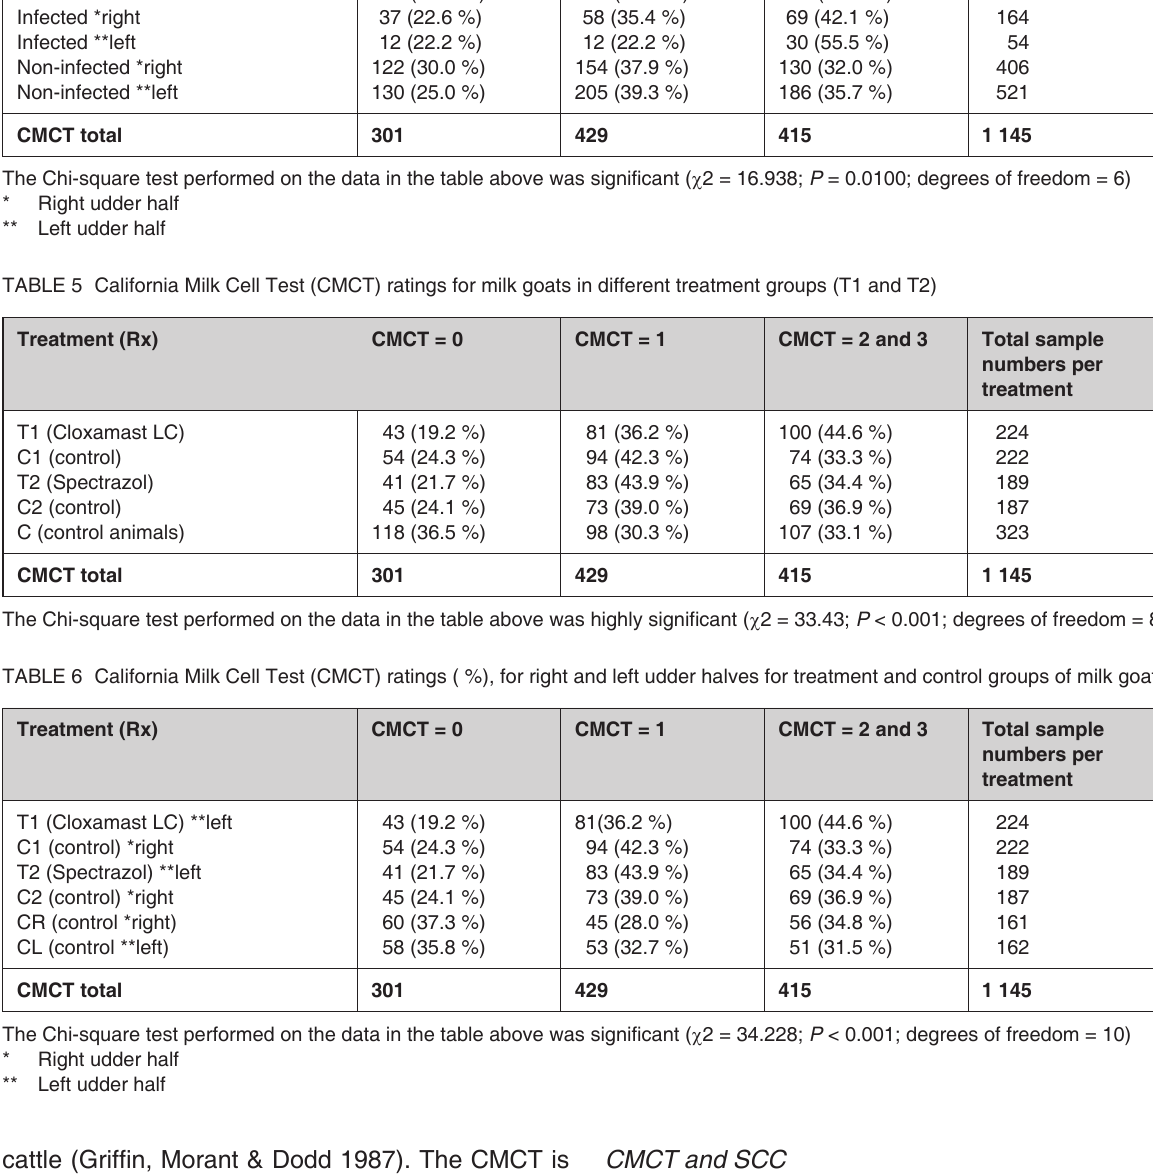
TABLE 4 California Milk Cell Test (CMCT) ratings ( %) for infected and uninfected udder halves of milk goats Udder halves CMCT = 0 CMCT = 1